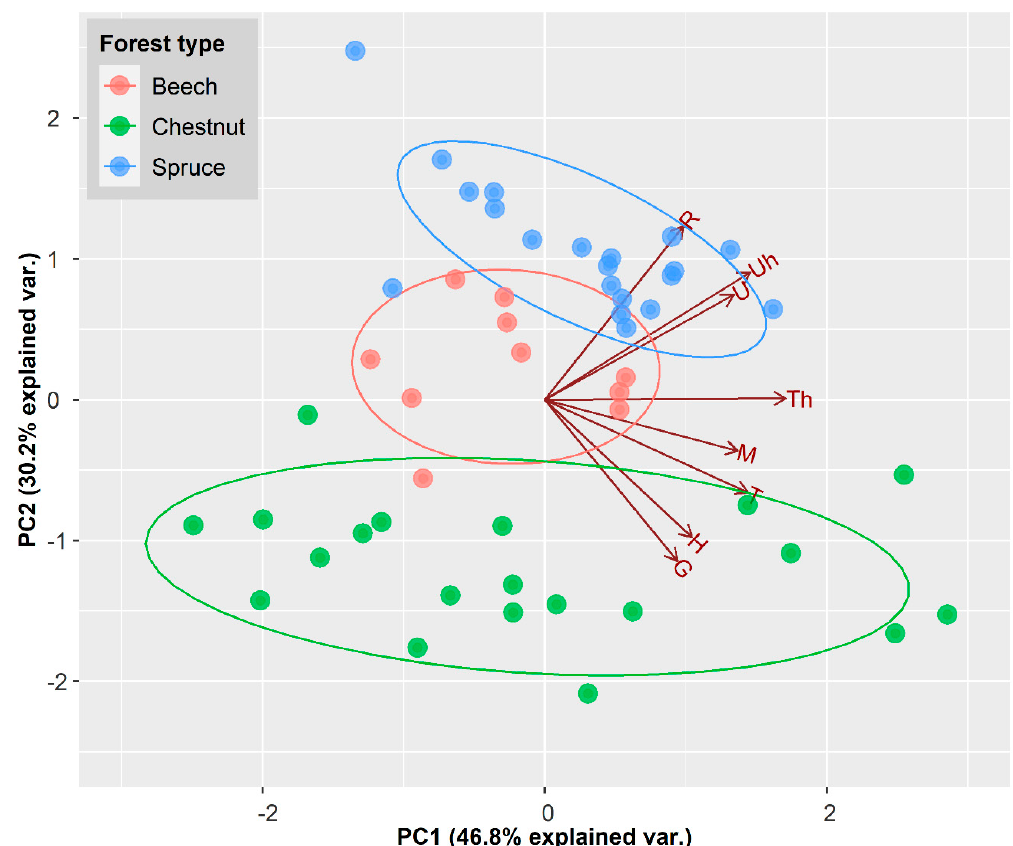
Figure 4. PCA biplot of the 50 sampling plots considering the values of the stand structural indices: Gini index (G), the Shannon index (H), the R aggregation index (R), the Diameter dominance index (U), the Diameter differentiation index (T), the Mingling index (M), the Tree height dominance index (Uh), and the Tree height differentiation index (Th). Clusters: beech = European beech forest, chestnut = sweet chestnut forest, spruce = Norway spruce forest.